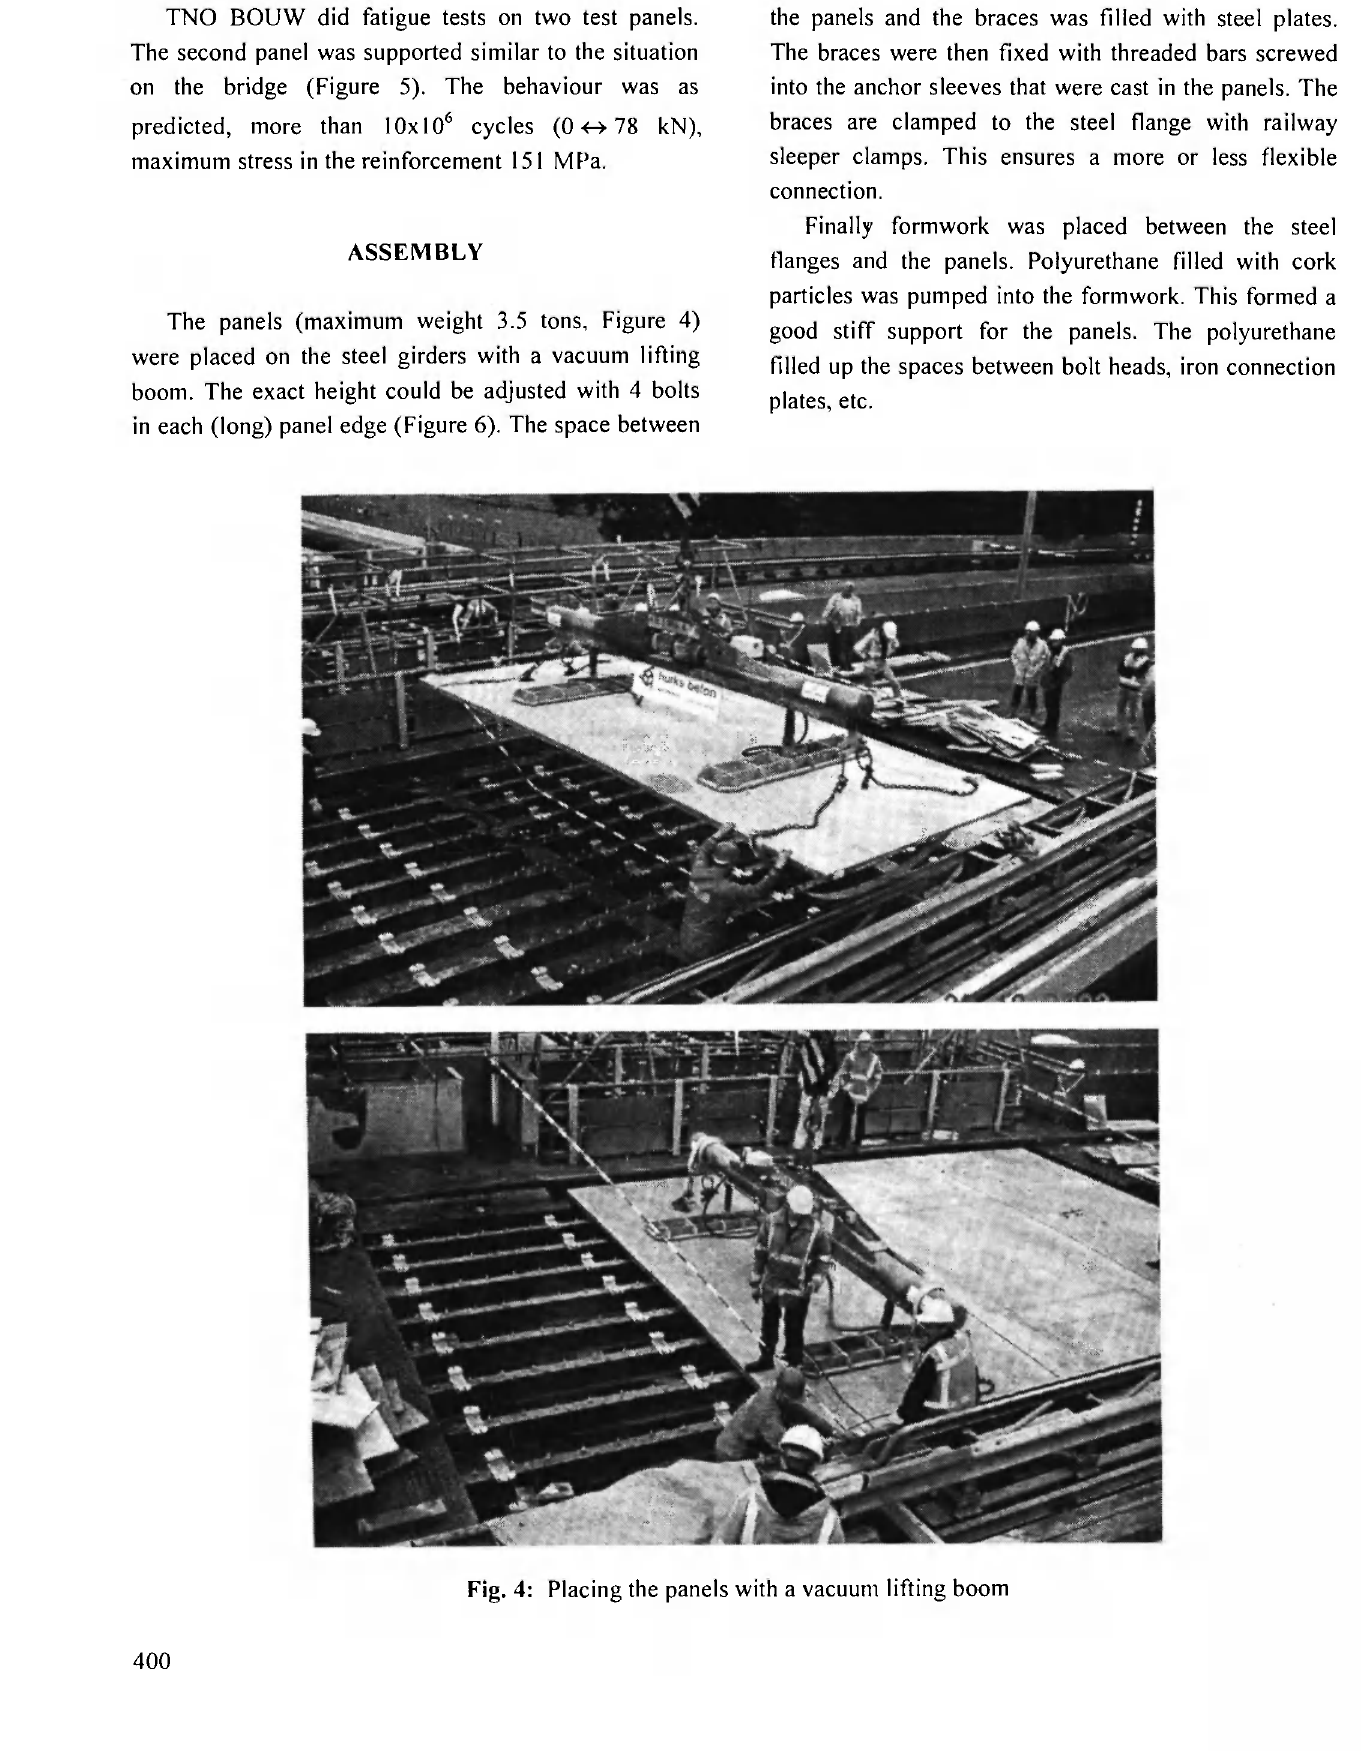
Fig. 4: Placing the panels with a vacuum lifting